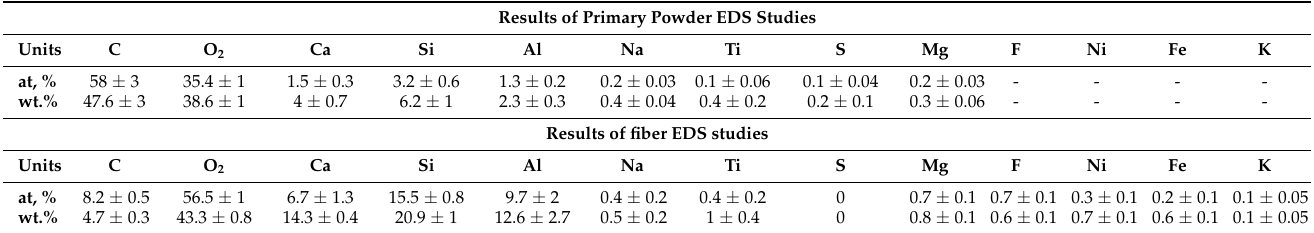
Table 1. Results of EDS studies on primary powders and fibers.